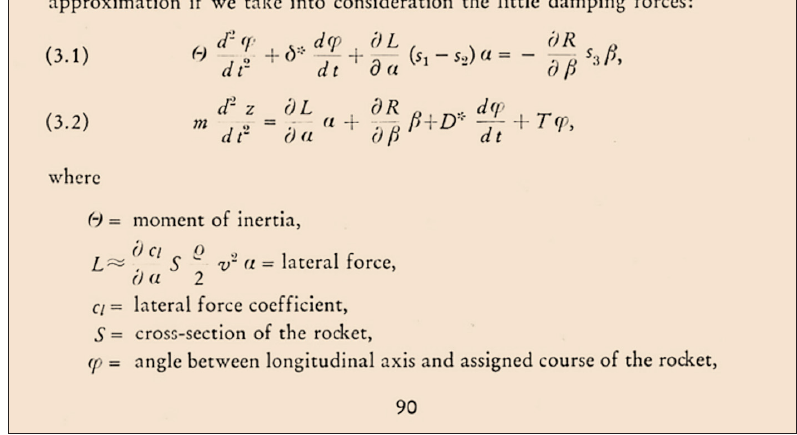
Figure 8: Source of Pynchon’s Second Equation. With illustration and explana- tions of some angles and parameters used in the equation for yaw control